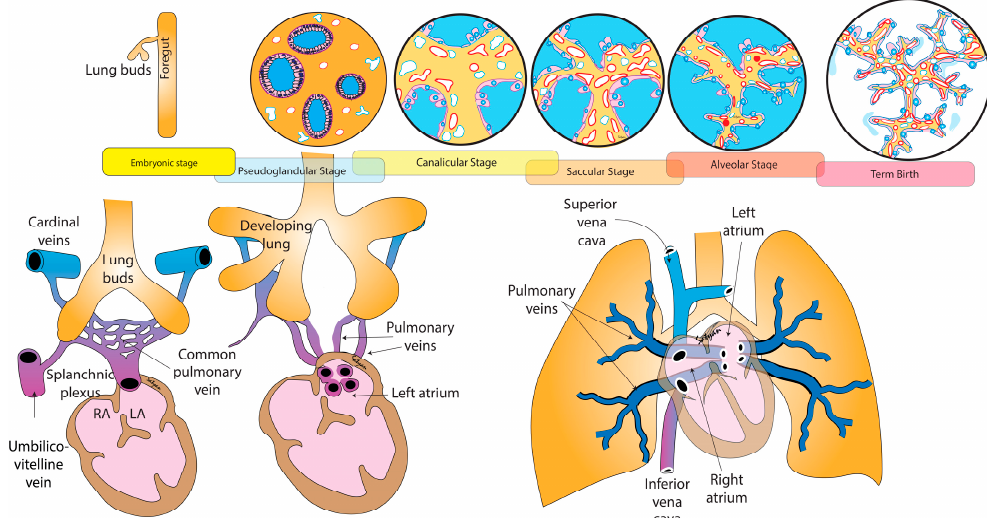
Figure 1. Development of pulmonary veins in relation to lung and cardiac development. The emerging lung buds are surrounded by splanchnic plexus connected to the umbilico-vitelline vein and the right and left cardinal veins. The pulmonary venous system drains to the left atrium through one common vein. Subsequently, there is organization of the venous network leading to four individual pulmonary veins draining into the left atrium. Copyright Satyan Lakshminrusimha.